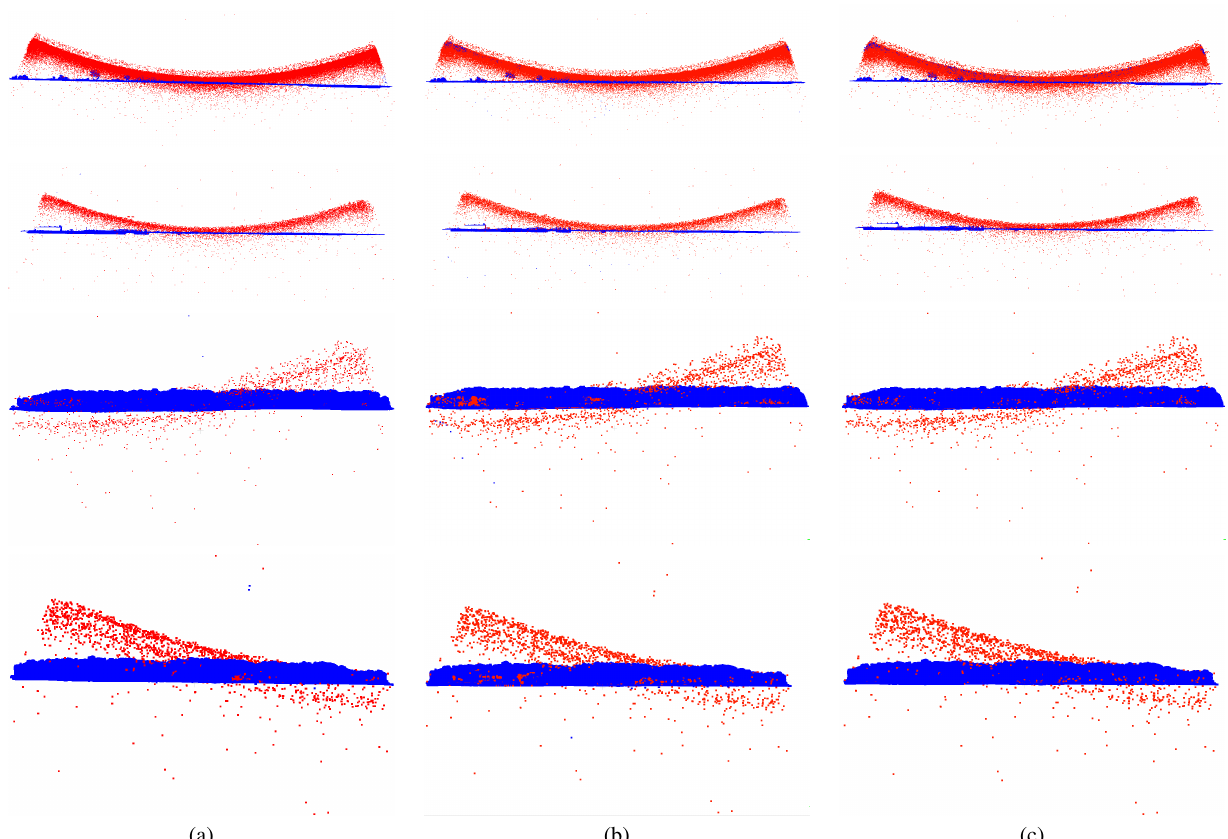
Figure 14: Visualization of results; a) Groundtruth, b) 3D U-Net (w/o aug.) and c) 3D U-Net (aug.). Red points are noise and blue points are regular non noise